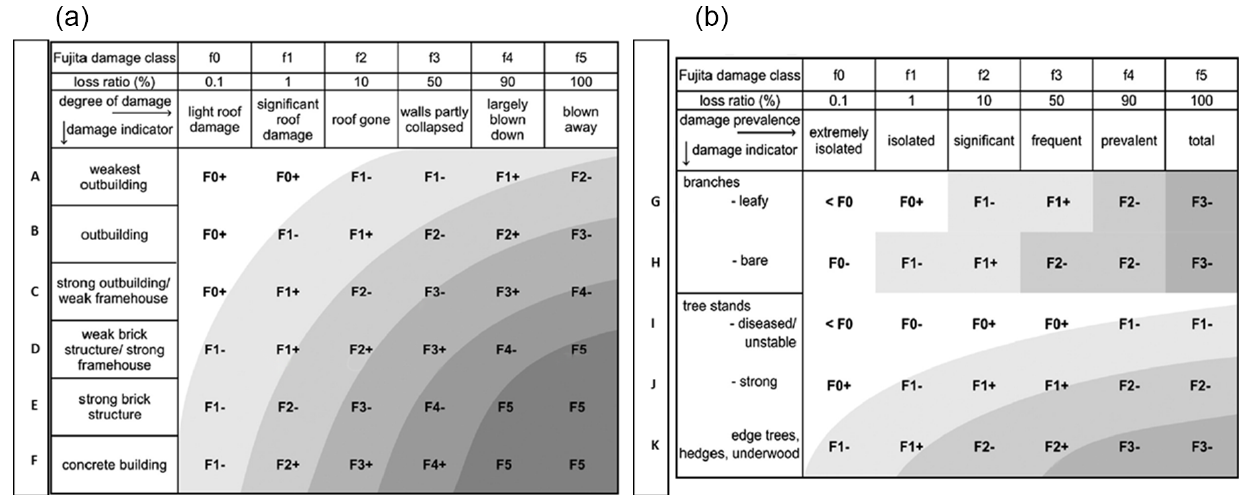
Figure 1. Damage rating matrices for buildings (a) and vegetation (b) , adapted from Feuerstein et al.